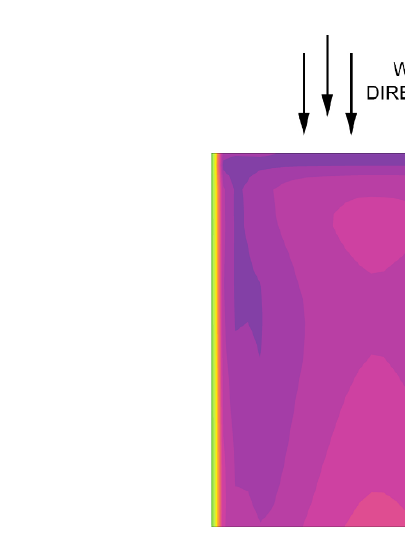
Figure 10. Wind velocity contour around the base skygarden model on ( a ) a central vertical plane through the centre of the skygarden, ( b ) a horizontal plane at occupants’ chest height (1.4 m).